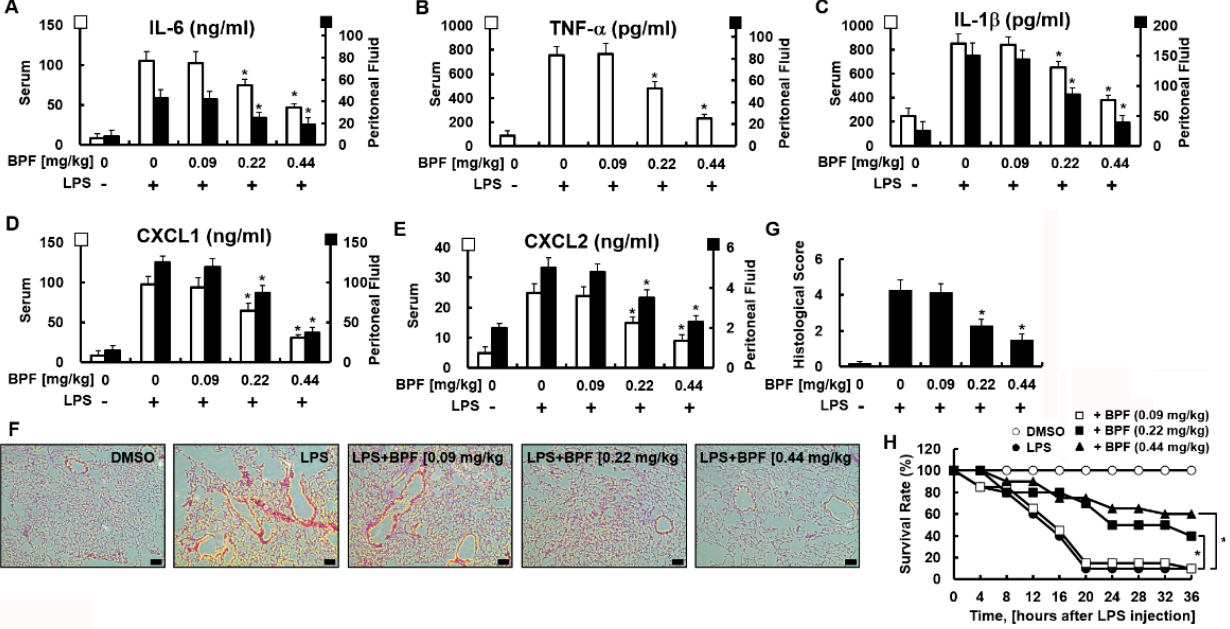
Figure 5. BPF alleviates excessive cytokine production and tissue damage of the lungs and improves the survival rate in the LPS-induced mouse septic shock model. ( A – E ) Mice were injected with 2.5 mg/kg of LPS (intraperitoneal injection) and DMSO or BPF (0.09, 0.22 or 0.44 mg/kg, intravenous injection). After 4 h, the mice were euthanized. Blood and peritoneal fluid were collected and the levels of the indicated inflammatory cytokines were determined using ELISA (n = 5). ( F , G ) Mice were injected with 2.5 mg/kg LPS (intraperitoneal injection) and DMSO or BPF (0.09, 0.22 or 0.44 mg/kg, intravenous injection). After 24 h, the mice were euthanized and the left lung lobes were collected and fixed in formalin, followed by staining with H&E. H&E staining of lung tissues from each group was conducted, and representative images from three independent experiments conducted on three different days are shown. The bar represents 200 µ m. Histopathological scores were obtained using an arbitrary scoring index based on the degree of inflammatory cell infiltration and the extent of the lesion area (n = 5). ( H ) Mice were injected with 25 mg/kg of LPS (intraperitoneal injection) and DMSO or BPF (0.09, 0.22 or 0.44 mg/kg, intravenous injection). The survival of the mice was monitored every 4 h for 36 h and the survival rates were expressed as a percentage (n = 20). All results are shown as the means ± SD of three different experiments with triple samples. * p < 0.5 compared to LPS